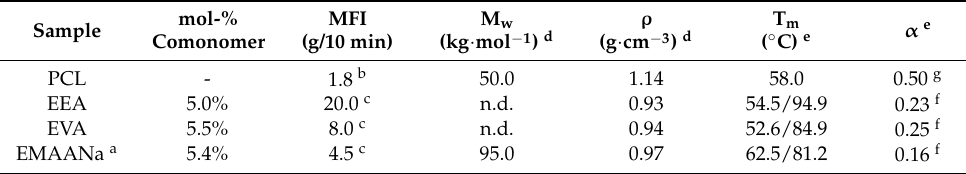
Table 2. Molecular and physical properties of copolymer samples (tie